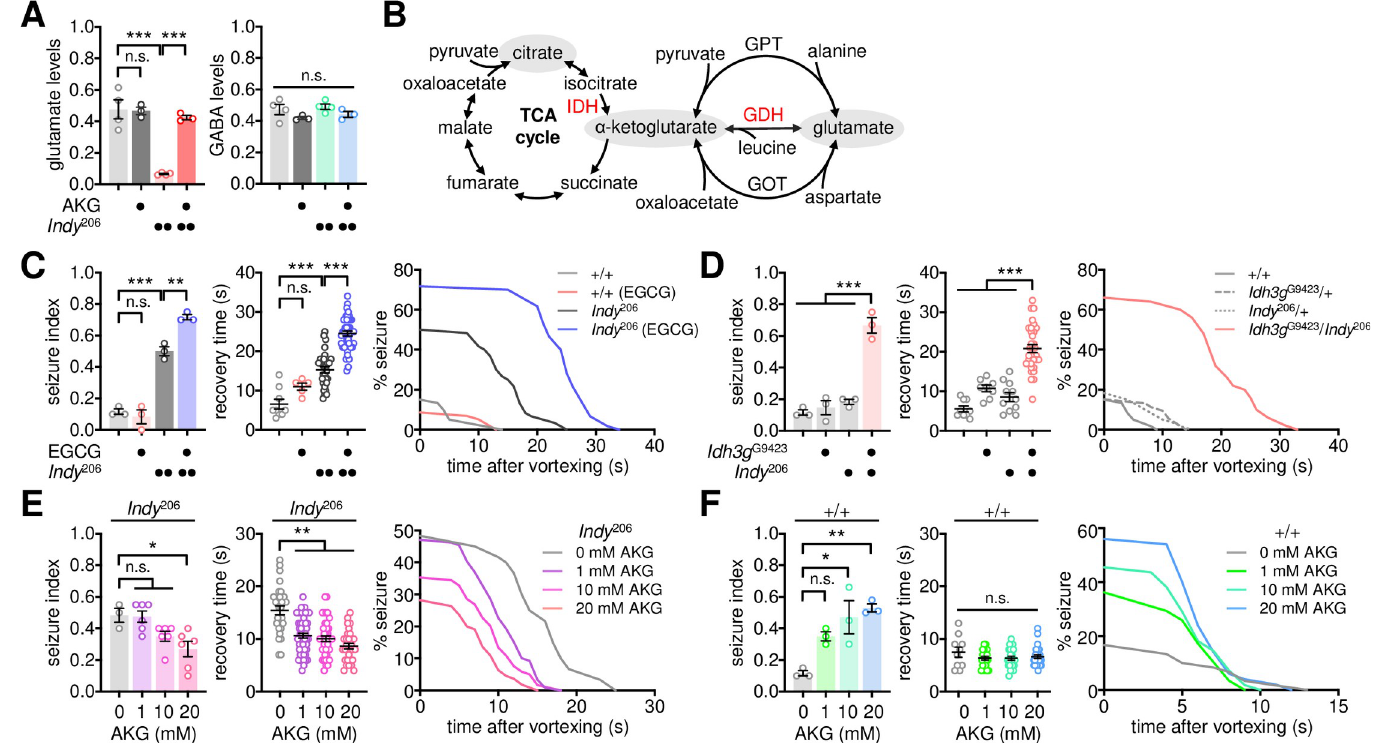
Fig 3. Indy -dependent BSS involves a metabolic link between the TCA cycle and glutamate transmission. (A) Indy mutants display low levels of free glutamate that are rescued by oral administration of α -ketoglutarate (AKG). Flies were fed control or AKG-containing food (20 mM) for 3 d before harvesting. Free amino acids in whole- body extracts were quantified using ion-exchange chromatography. Relative levels of glutamate and GABA were calculated by normalizing to glycine levels. A significant Indy x AKG interaction effect on glutamate levels ( P = 0.0006) was detected by two-way ANOVA. Data represent means ± SEM (n = 3–4). n.s., not significant; ��� P < 0.001, as determined by Holm-Sidak’s multiple comparisons test. (B) Glutamate biosynthesis via the TCA cycle. IDH, isocitrate dehydrogenase; GDH, glutamate dehydrogenase; GPT, glutamate-pyruvate transaminase; GOT, glutamate-oxaloacetate transaminase. (C) Oral administration of the GDH inhibitor epigallocatechin gallate (EGCG) exaggerates BSS phenotypes in Indy mutants. Flies were fed control or EGCG-containing food (5 mg/ml) for 3 d before the BSS assessment. Quantitative analyses of BSS in individual flies were performed as described in Fig 1. Two-way ANOVA detected a significant Indy x EGCG interaction effect on seizure index ( P = 0.0025). Data represent means ± SEM (seizure index, n = 58–60 flies in 3 independent experiments; recovery time, n = 5–43 flies). n.s., not significant; �� P < 0.01, ��� P < 0.001, as determined by Holm-Sidak’s multiple comparisons test. (D) Idh3g heterozygosity induces BSS phenotypes in heterozygous Indy mutants. Significant Indy x Idh3g interaction effects on seizure index ( P = 0.0002 by two-way ANOVA) and recovery time ( P = 0.0086 by Aligned ranks transformation ANOVA) were detected. Data represent means ± SEM (seizure index, n = 50–60 flies in 3 independent experiments; recovery time, n = 8–33 flies). ��� P < 0.001, as determined by Holm-Sidak’s multiple comparisons test (seizure index) or by Wilcoxon rank sum test (recovery time). (E and F) Oral administration of AKG rescues BSS phenotypes in Indy mutants. Flies were fed control or AKG-containing food (20 mM) for 3 d before the BSS assessment. Data represent means ± SEM (seizure index, n = 50–119 flies in 3 independent experiments; recovery time, n = 10–56 flies). n.s., not significant; � P < 0.05, �� P < 0.01, as determined by one-way ANOVA with Holm-Sidak’s multiple comparisons test (seizure index), by Welch’s ANOVA with Dunnett’s T3 multiple comparisons test (E, recovery time), or by Kruskal-Wallis test with Dunn’s multiple comparisons (F, recovery time).